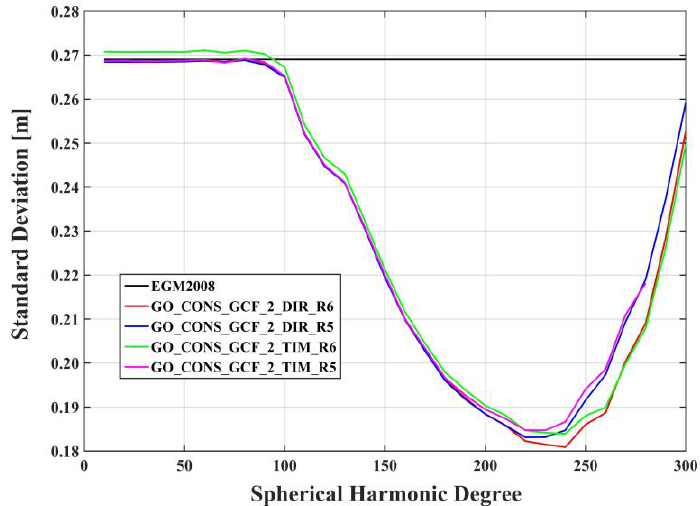
Figure 8. Standard deviations of the height anomalies differences between GNSS/leveling and the refined GFMs with varying expansion d/o.